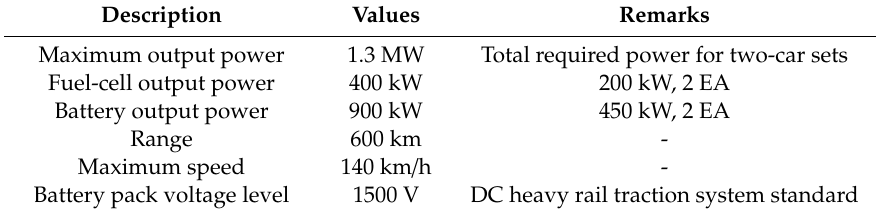
Table 1. Specifications for the propulsion system of fuel-cell powered railroad vehicle.